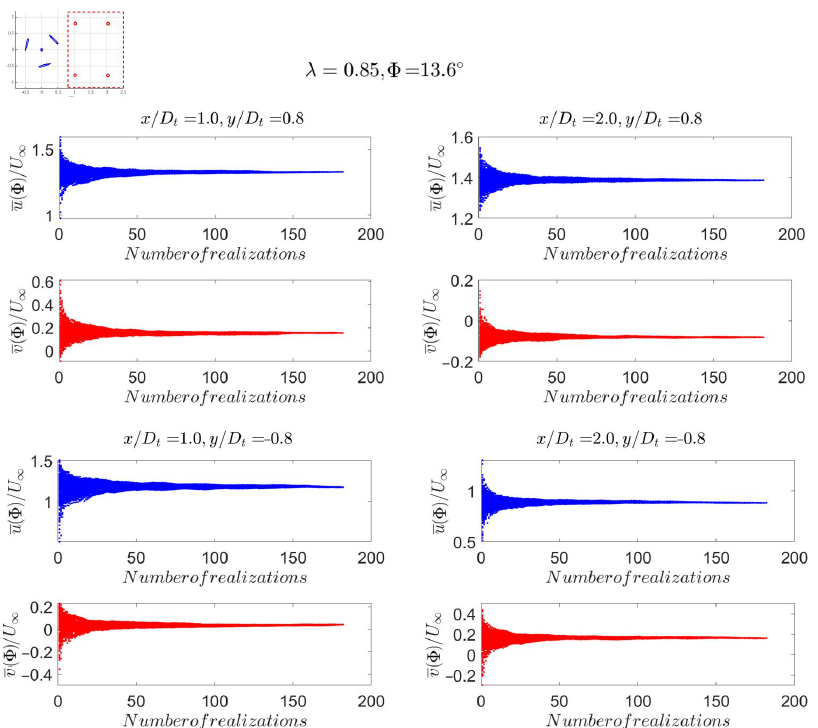
Figure 10. An example of the flow converged over more than 100 phases of the T2 configuration at λ = 0.85 and at Φ = 13.6 ◦ . The vertical axes are the streamwise and transverse velocities, at the 4 points highlighted in Figure 5, averaged over